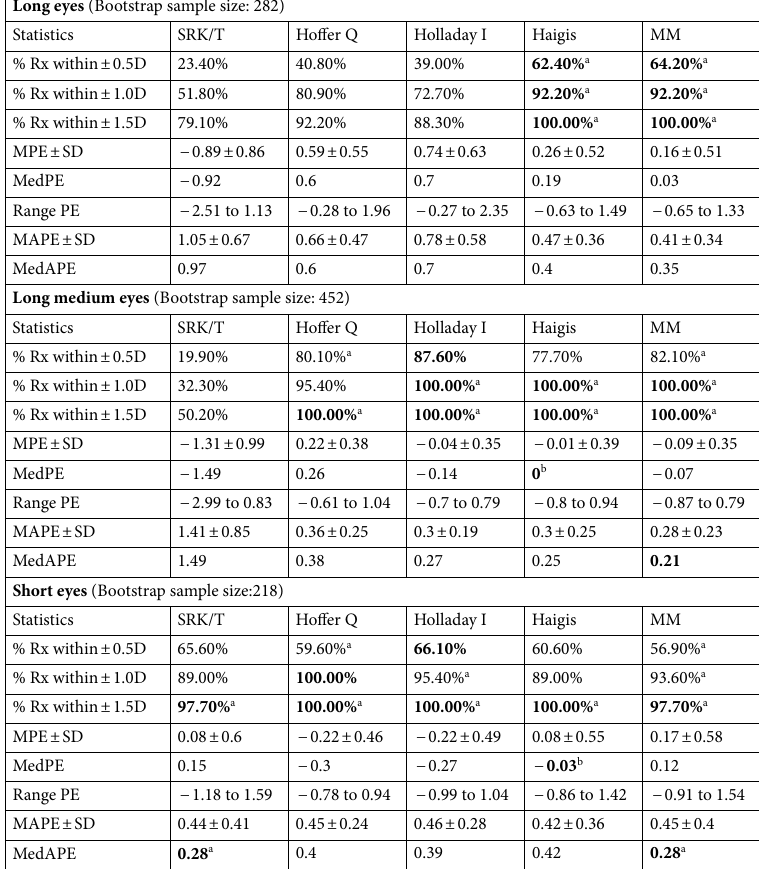
Table 2. Summary statistics of the cross-validation results for each of the five formulae (SRK/T, Hoffer Q, Holladay I, Haigis and MM) for long, long medium and short eyes. % Rx Percentage of eyes within a given range of prediction error, MPE Mean prediction error, MedPE Median prediction error, Range PE Range of the prediction error, MAPE Mean absolute prediction error, MedAPE Median absolute prediction error, SD Standard Deviation of the error. a No statistically significant difference at level 0.05. b No statistically significant difference from zero at level 0.05. Significant values are in